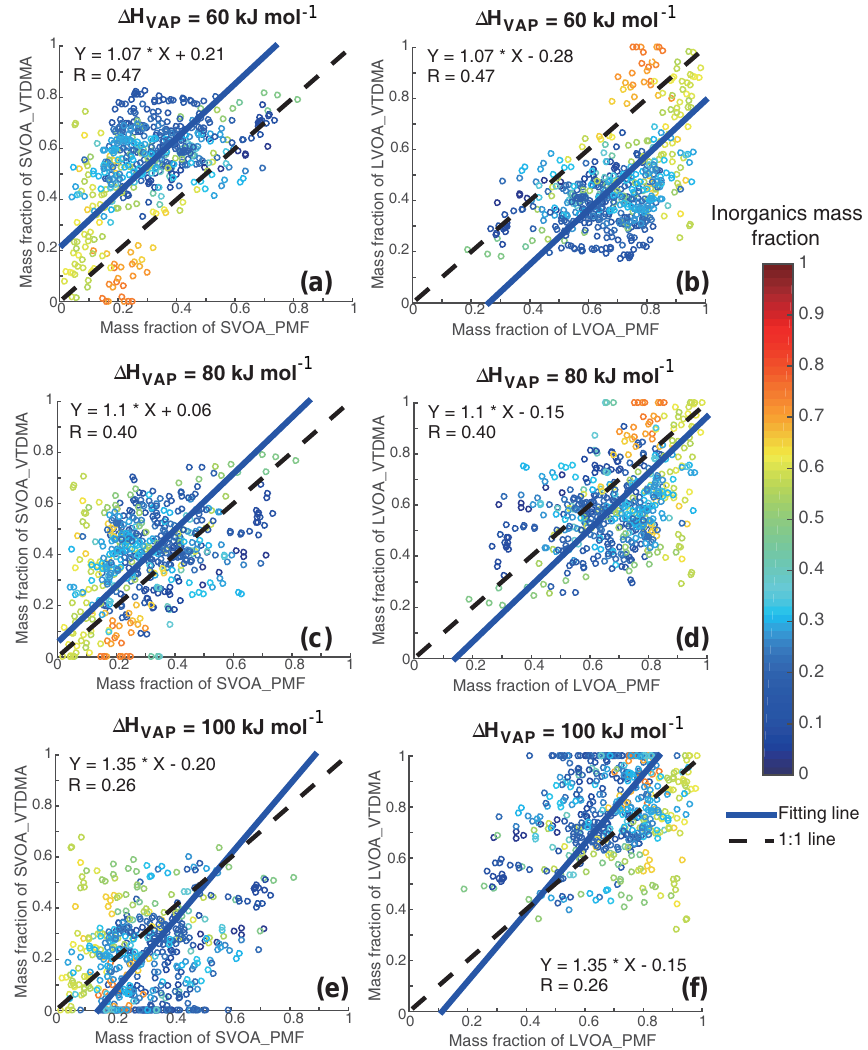
Figure 5. Mass fractions of SVOA and LVOA of the total organic mass obtained from VTDMA data vs. the ones from the PMF analysis. Here, the y axis represents the VTDMA results interpretation using the kinetic model and the x axis represents the AMS results interpretation using the statistical model (PMF). Model results were obtained by using a constant enthalpy value for all organics, corresponding to Combination 1 ( a and b ), Combination 2 ( c and d ) and Combination 3 ( e and f ) in Table 2. The LVOA_VTDMA here is the sum of LVOA and ELVOA mass fractions. The colors of the data points illustrate the inorganic mass fraction in the particles. Correlation coefficient and equation for the line fitted to the data points are given in the